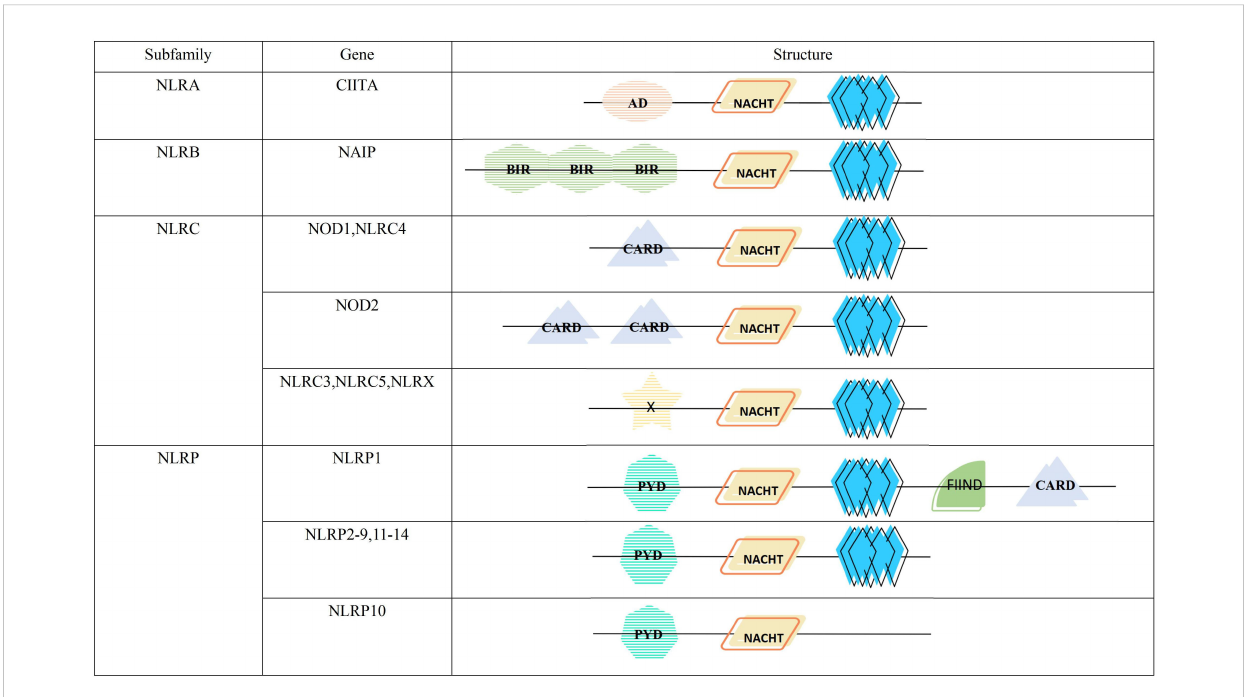
FIGURE 1 Structure and classi fi cation of the NLR family. AD, acidic transactivation domain; NACHT, NACHT domain (consisting of seven distinct con-served motifs, including the ATP/GTPase-speci fi c P-loop, the Mg2+-binding site, and fi ve more-speci fi c motifs); BIR, baculovirus inhibitor of apoptosis repeat; CARD, caspase activation and recruitment domain; X, unidenti fi ed; PYD, pyrin domain; FIIND, function to fi nd domain; leucine-rich